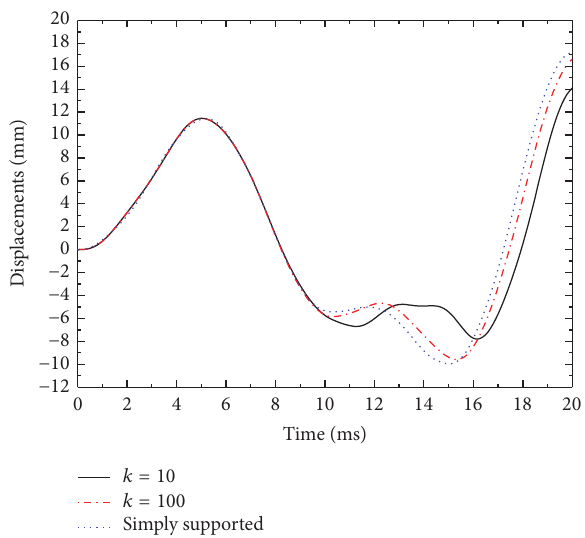
Figure 8: Transverse displacement history at the exciting point with different restraints.